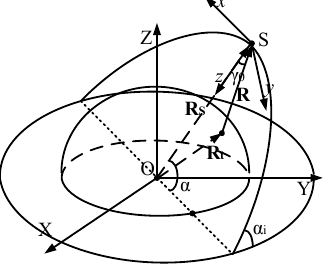
Figure 1. The geometry of ECI and MCO CS.